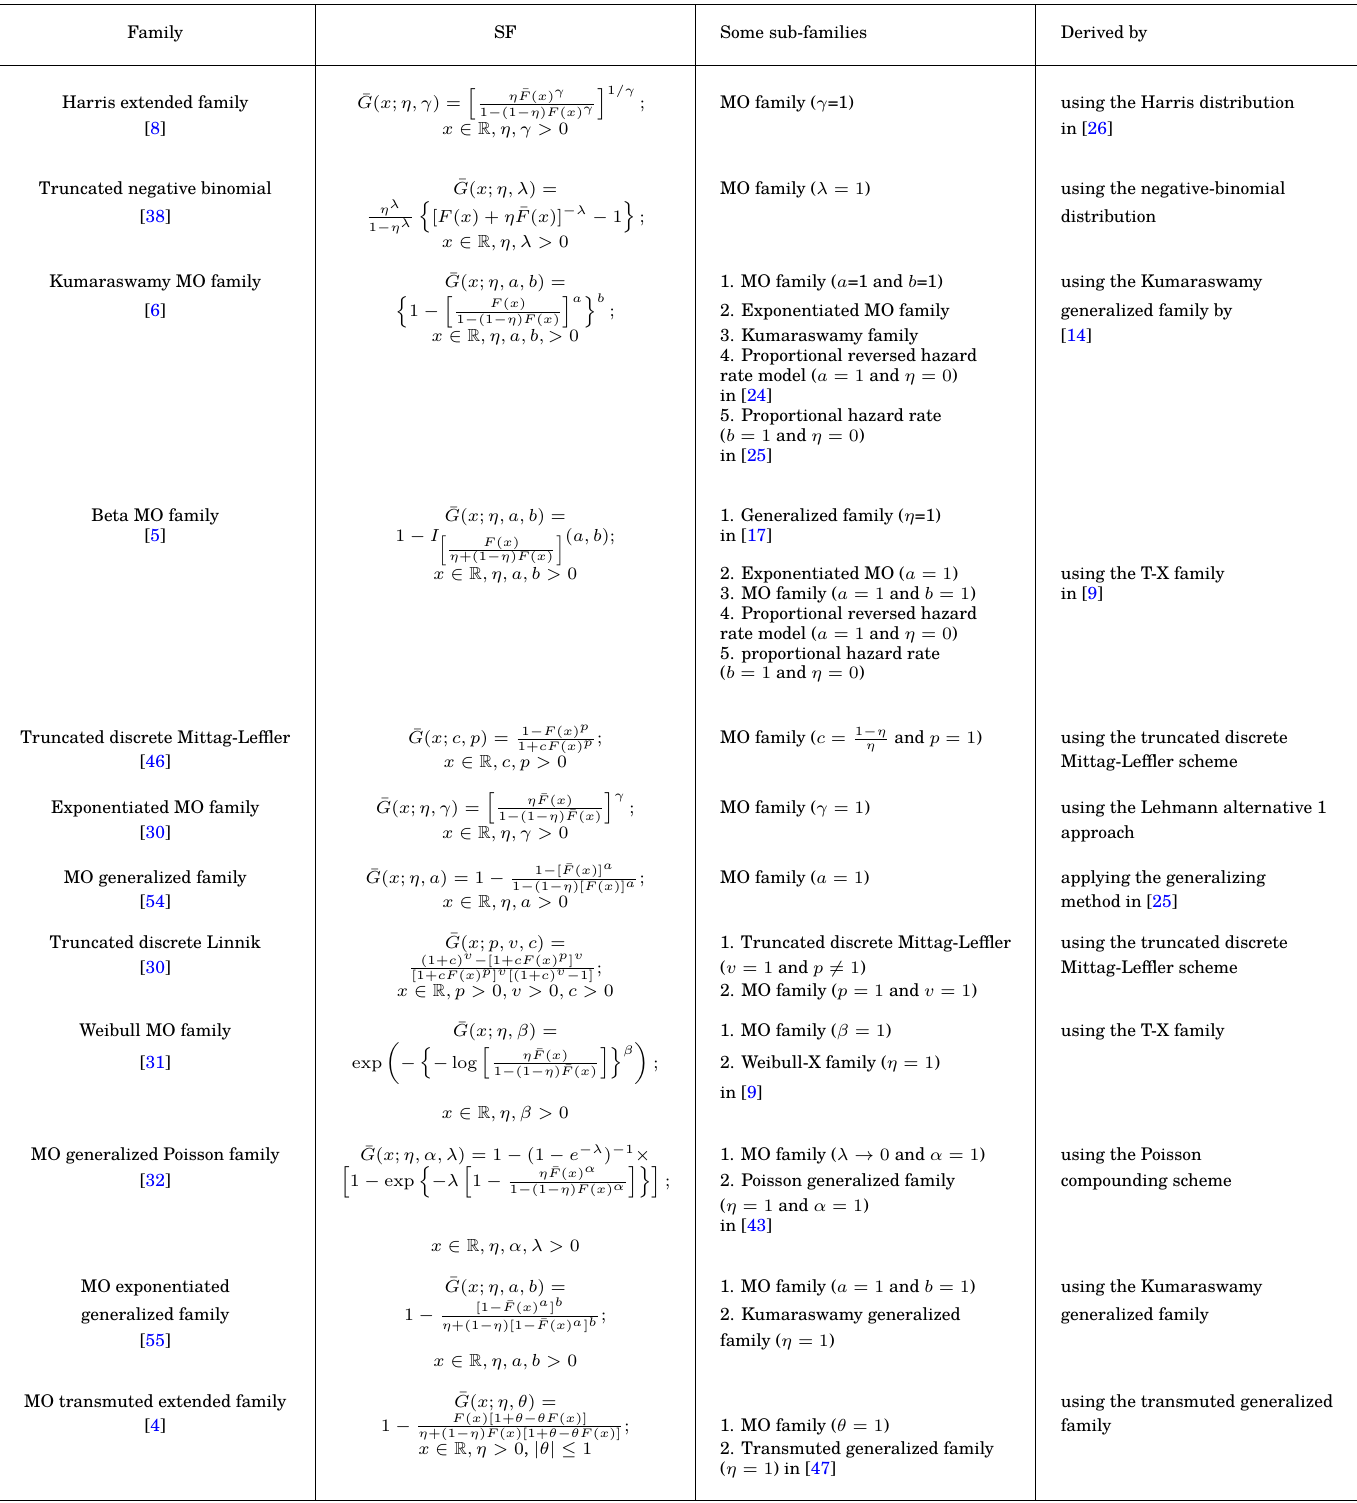
Table 1: Various generalized MO families of